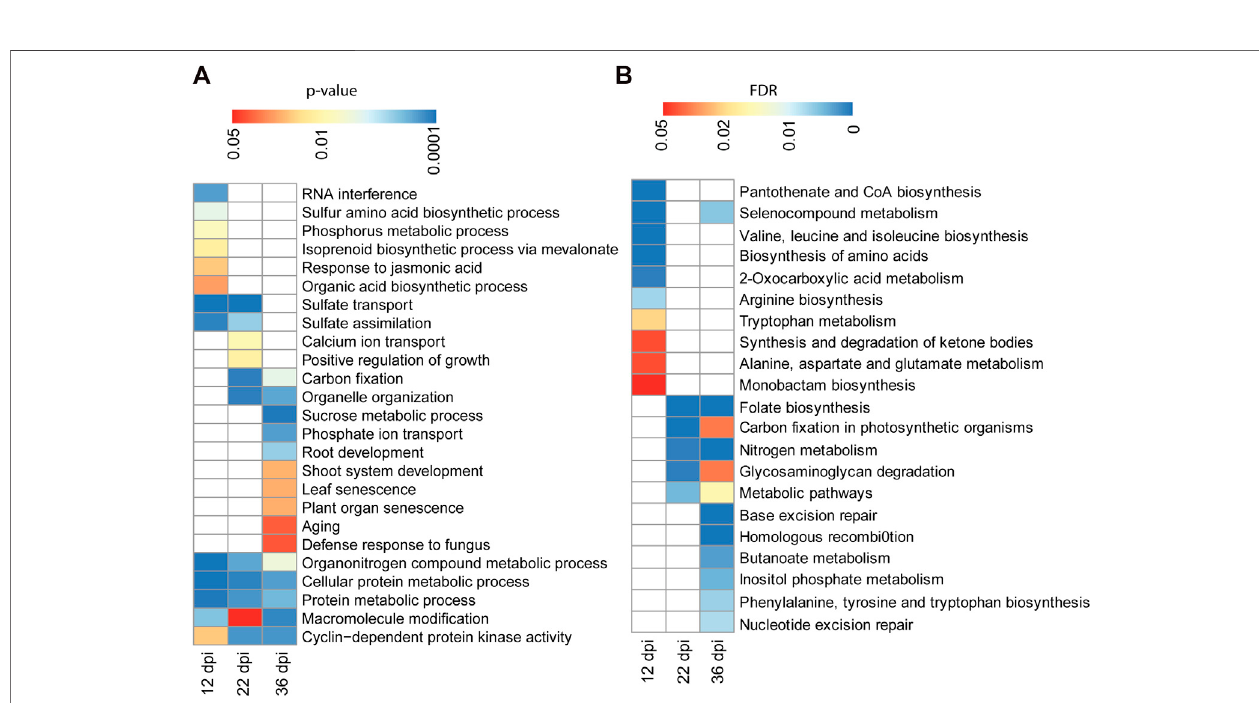
FIGURE 6 | GO term and pathway analysis for the identi fi ed targets of differentially methylated miRNAs. (A) : GO term enrichment analysis for 206, 496, and 537 target genes of the differentially methylated miRNAs identi fi ed at 12, 22, and 36 dpi, respectively. Enrichment analysis was performed using Fisher ’ s exact test with p < 0.05. (B) :KEGGpathwayanalysisfor206,496,and537targetgenesofthedifferentiallymethylatedmiRNAsidenti fi edat12,22,and36dpi,respectively.Enrichment analysis was performed using Fisher ’ s exact test and Benjamini and Hochberg FDR < 0.05.